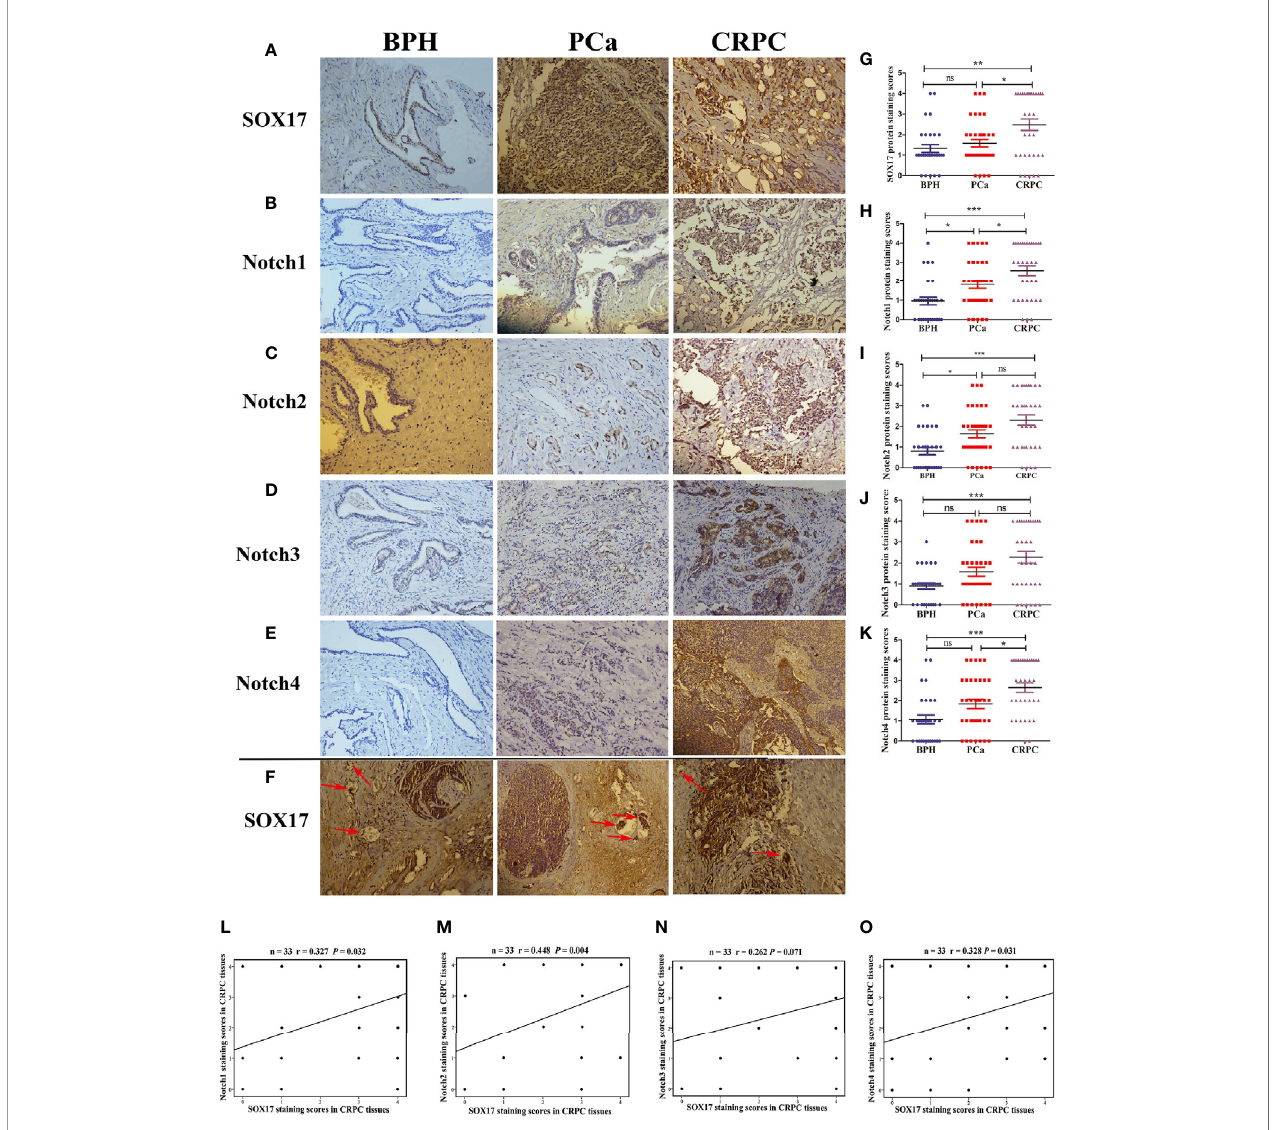
FIGURE 1 | The expression of SOX17 and Notch receptors in samples of benign prostatic hyperplasia (BPH), prostate cancer (PCa) and castration-resistant prostate cancer (CRPC). (A – E) The expression levels of SOX17, Notch1 and Notch2, Notch3, Notch4 were detected by using immunohistochemistry (×200). (F) The positive expression of SOX17 in cancer thrombus of CRPC (red arrows) (×200). (G – K) Average staining scores for SOX17, Notch1, Notch2, Notch3, Notch4 BPH, PPC and CRPC samples. Staining scoring, according to staining intensity, was de fi ned as 0, no staining; 1, weak staining; 2, light staining; 3, moderate staining; and 4, strong staining. Staining scores of ≤ 1 were de fi ned as negative expression, while staining scores of ≥ 2 were de fi ned as positive expression. (L – O) The correlation curve analysis for SOX17 staining scores versus Notch1 and Notch2, Notch3, Notch4 staining scores in CRPC tissues. Values of P < 0.05 were considered to be statistically signi fi cant. *P < 0.05, **P < 0.01, ***P < 0.001, ns, no signi fi